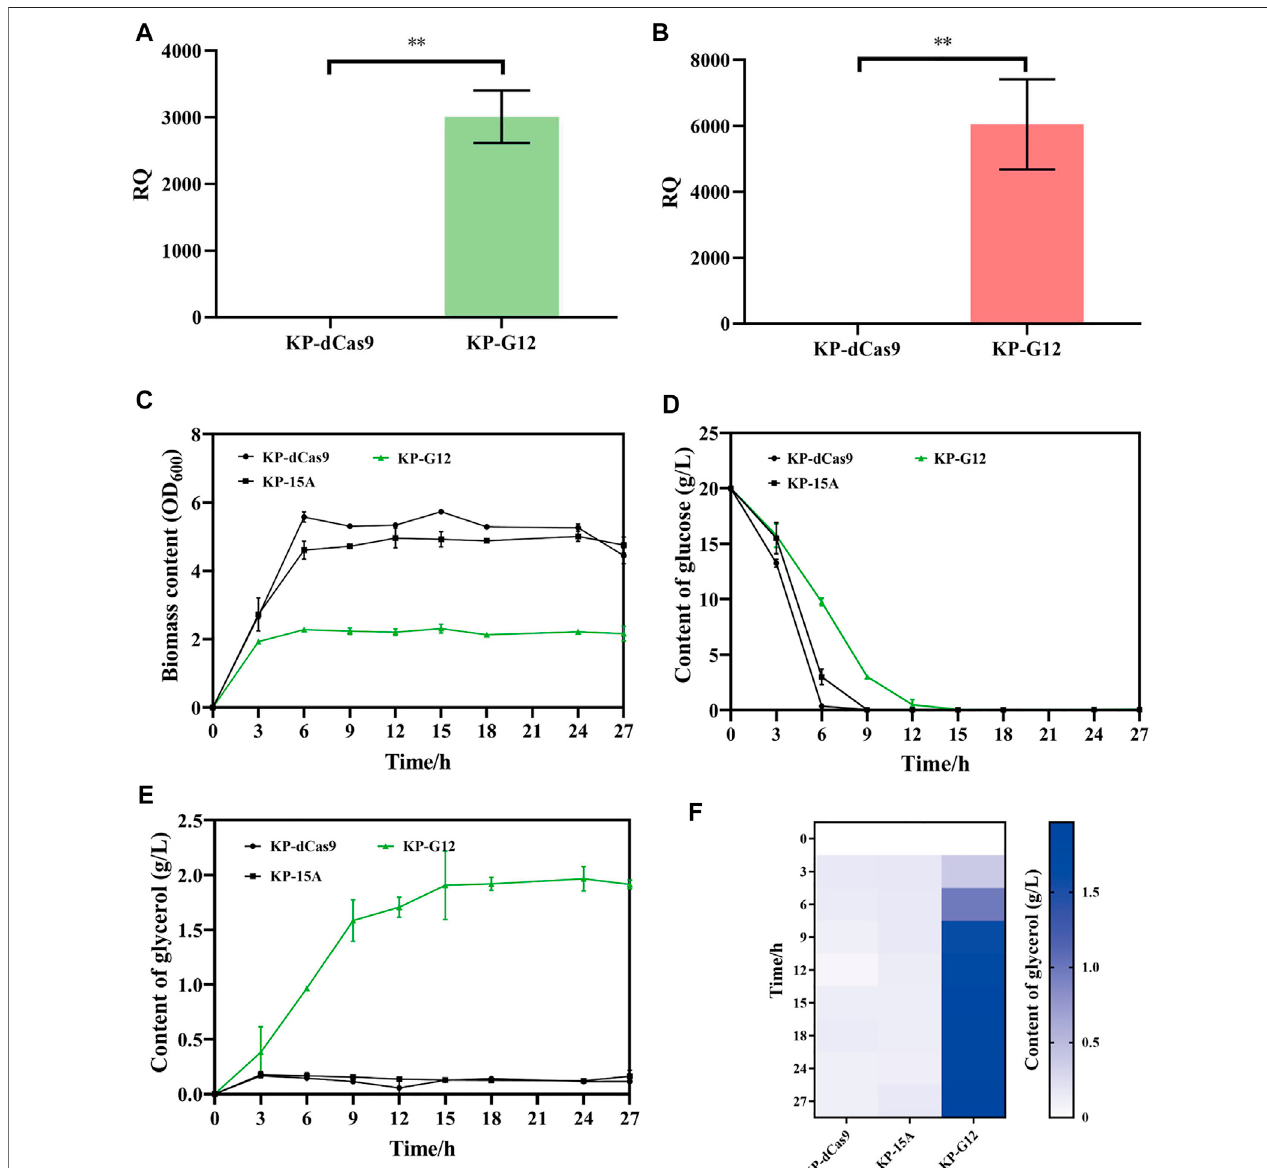
FIGURE 3 | Performance of strains in shake fl asks. (A) Relative quantity of gpd1 gene transcription. (B) Relative quantity of gpp2 gene transcription. KP-dCas9 indicates the recombinant K. pneumoniae with dCas9 integrated in genome, and its 16S rRNA serves as the internal reference gene. (C) Glucose level after 24 h fermentation. (D) OD 600 after 24 h fermentation. (E) Line chart represents the glycerol level. (F) Heatmap of the glycerol level. KP-dCas9 indicates the recombinant K. pneumoniae with dCas9 integrated in genome. KP-15A indicates the recombinant K. pneumoniae harboring plasmid ptac-15A and serves as a control. KP-G12 indicates the recombinant K. pneumoniae harboring plasmid ptac-G12 co-expressing gpd1 and gpp2 genes. RQ, relative quantity of transcription. * p < 0.05 and ** p <